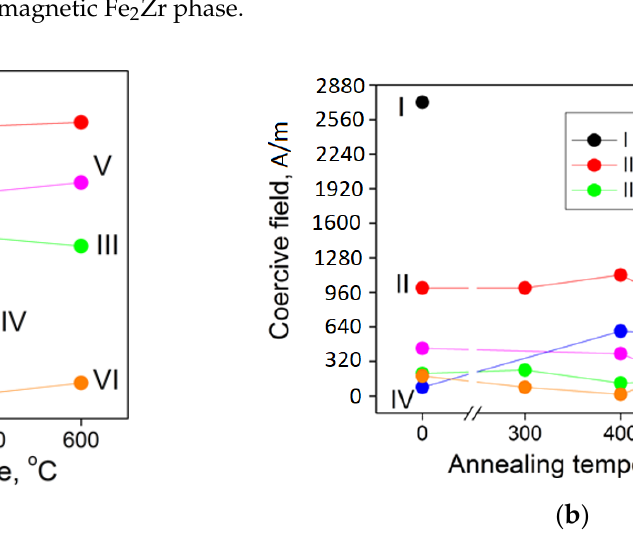
Figure 8. Saturation induction ( a ) and coercive field ( b ) of the films.